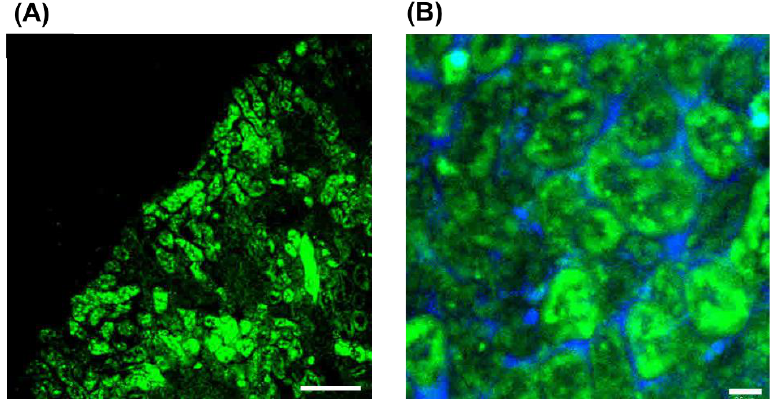
Figure 3. Intrarenal distribution of FITC-labeled Ser-poly-L-lysine (Ser-PLL) in tissue sections 60 min after intravenous injection into mice. ( A ) Renal cortex (scale bar = 200 μm) and ( B ) magnified image of cortex (scale bar = 25 μm). Fluorescence intensity was observed under a laser-scanning confocal microscope.